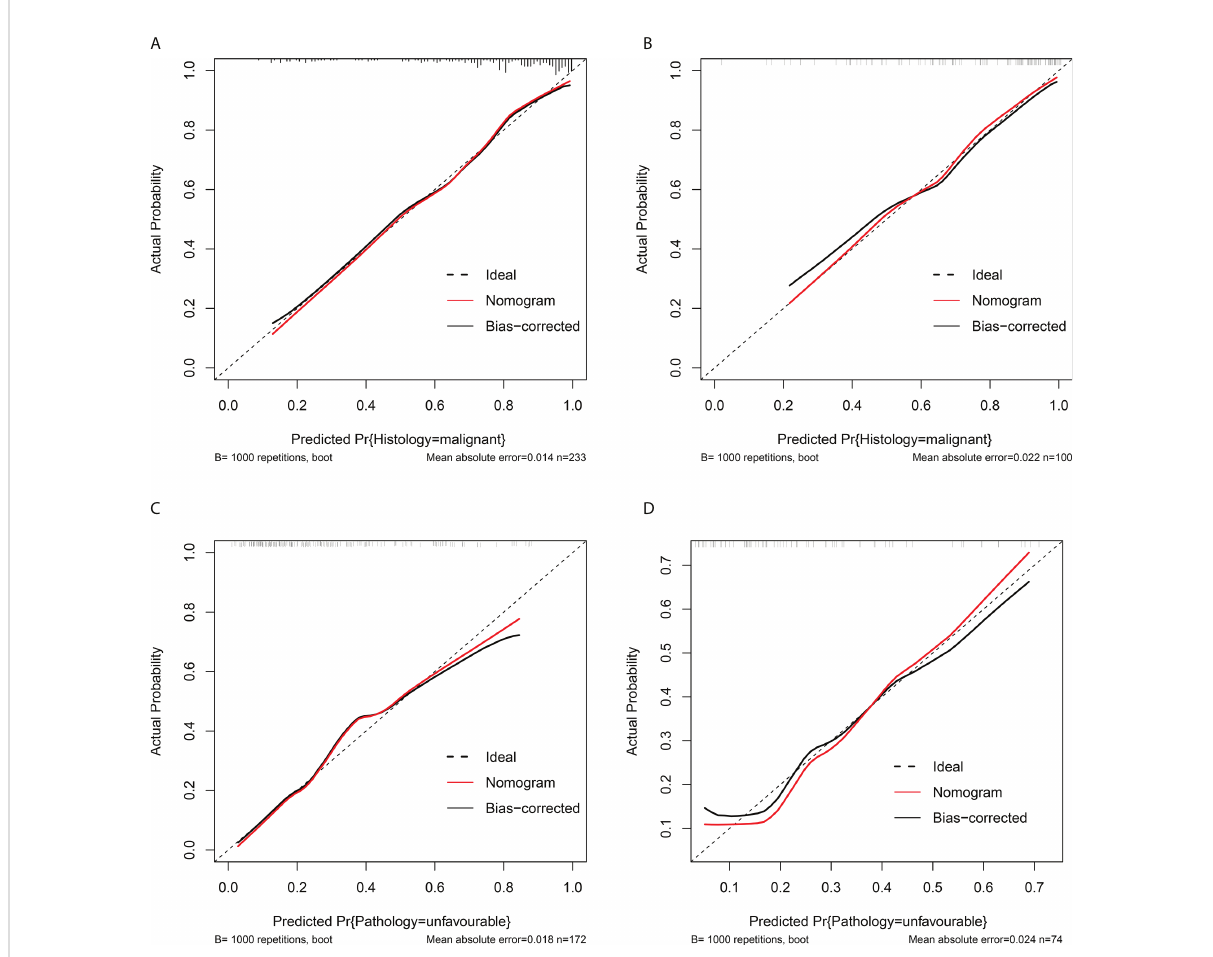
FIGURE 4 Calibration curves of the malignant histology-risk nomogram (A, B) and unfavorable pathology-risk nomogram (B, D) in the training set (A, C) and the validation set (B, D) . The 45° dotted diagonal line represents a perfect prediction, the red dashed line represents the predictive performance of the nomogram, together with a bias-corrected black solid